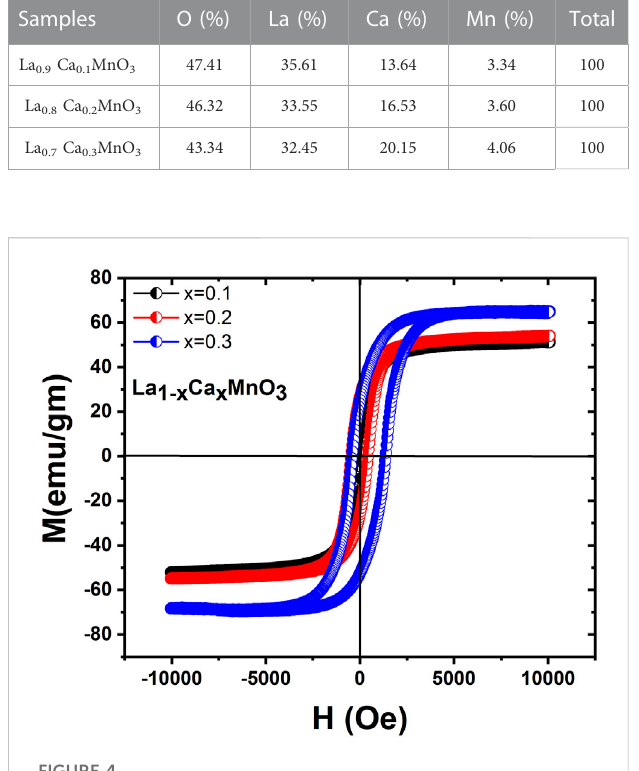
TABLE 2 Saturation-magnetization (M s ), remanent/saturation-magnetization (M r /M s ), remanent magnetization (M r ), and coercive- fi eld (H c ) of La 1-x Ca x MnO 3 (x = 0.1, 0.2, and 0.3).